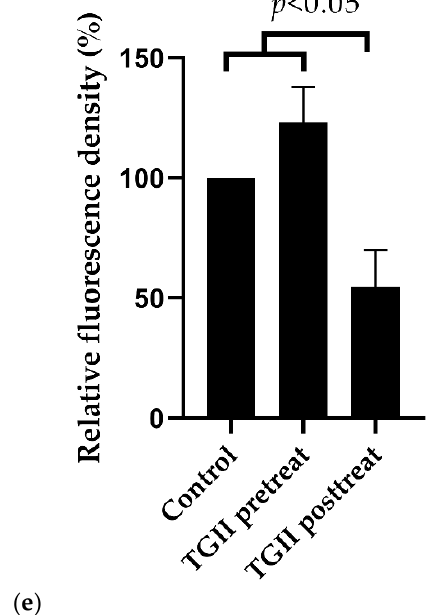
Figure 3. TGII regulates the expression and the penicillin-binding ability of penicillin-binding protein 2a (PBP2a) in the MSRA strain. The clinically isolated MRSA was treated with oxacillin alone or oxacillin in combination with TGII by following the procedures described in the Materials and Methods section. The present data (shown as mean ± SD, n = 3) reveal the following: ( a ) mecA mRNA expression determined using qPCR; ( b ) PBP2a expression determined using Western blot analysis; and ( c ) the quantitative graph of Western blot from ( b ); MRSA treated with oxacillin or oxacillin combined TGII were normalized to control cells, respectively; ( d ) PBP2a latex agglutination test; ( e ) the relative fluorescence density of BOCILLIN FL; the protein lysates were incubated with BOCILLIN FL for 30 min according to the following conditions: control (without TGII treatment), TGII pretreat (TGII treatment before protein extraction), and TGII posttreat (TGII treatment after protein extraction).